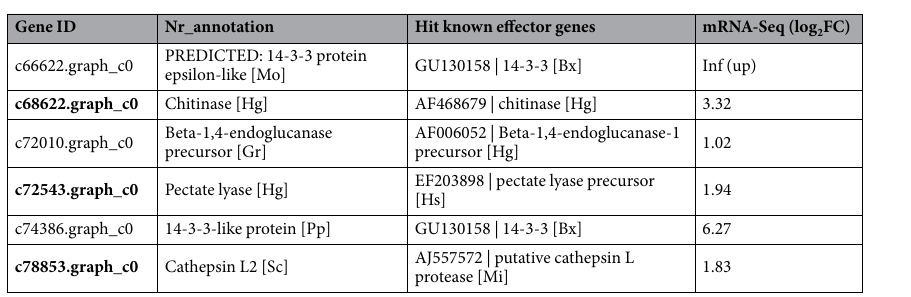
Table 5. Predicted effector genes mined from differentially expressed genes of Heterodera avenae when exposed to wheat roots. Bx: Bursaphelenchus xylophilus , Gr: Globodera rostochiensis , Hg: Heterodera glycines , Hs: Heterodera schachtii , Mi: Meloidogyne incognita , Mo: Metaseiulus occidentalis , Pp: Physarum polycephalum , and Sc: Sinonovacula constricta . Known effector genes are shown as GenBank Accession numbers followed by gene description. Inf (up) indicated the expression of the gene was detected only in the treatment sample, but not in the control sample. The genes marked in bold were validated by qPCR (Table 2). FC, fold change (treatment versus